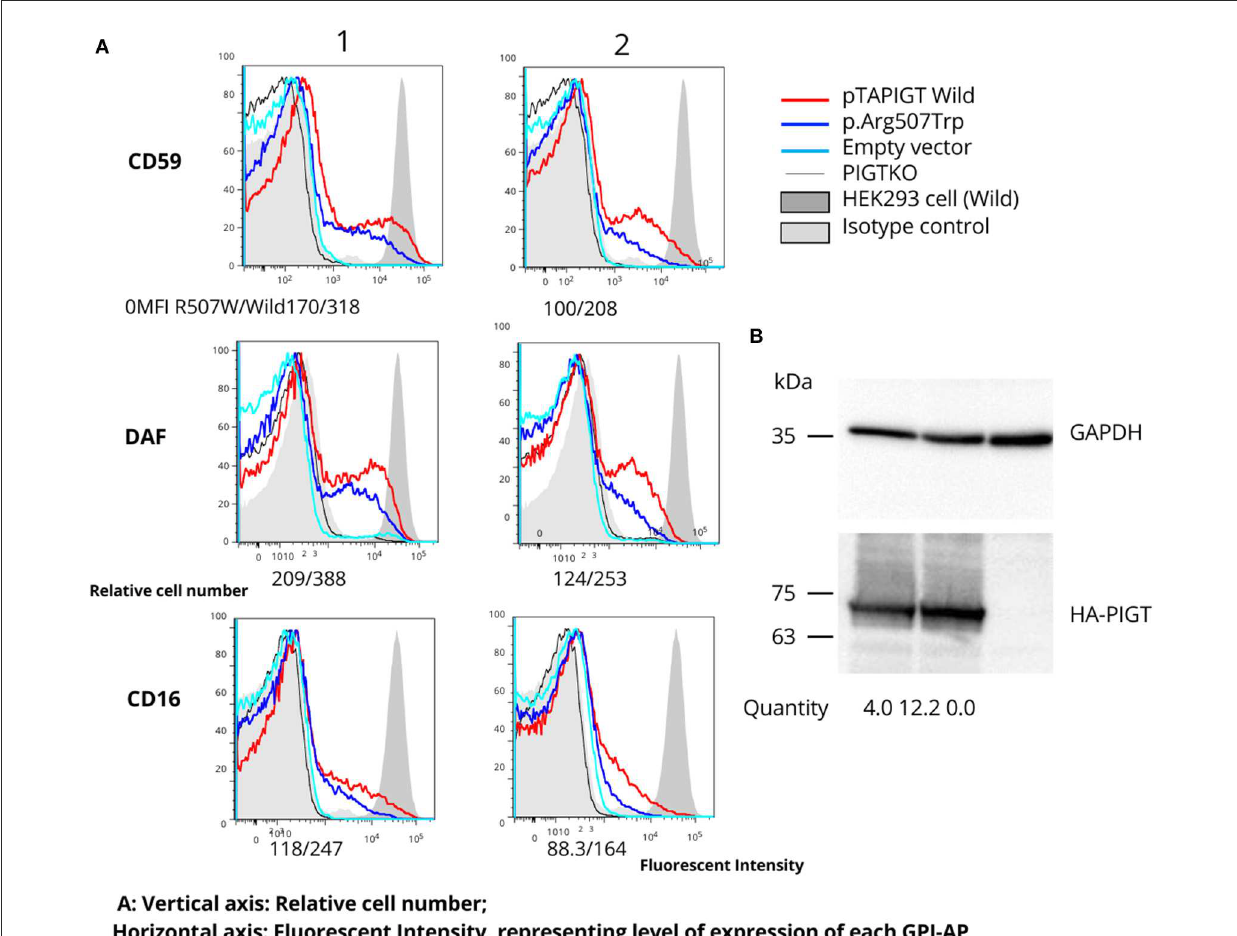
FIGURE2 Follow-up functional studies on the p.Arg507Trp variant. (A) PIGT knockout HEK293 cells were transfected with variable amounts of p.Arg507Trp-variant PIGT or wild-type PIGT expressing plasmids driven by the weak promoter (pTA; 1: 4 ug; 2: 0.8 ug). Restoration of expression of GPI-APs (CD59, DAF, and CD16) was measured using flow cytometry. The p.Arg507Trp variant could not restore GPI-APs at a similar level to wild-type PIGT . The vertical axis represents the relative cell number; the horizontal axis represents fluorescent intensity, reflecting the level of expression of each GPI-AP. (B) Levels of expressed wild-type and p.Arg507Trp mutant HA-tagged PIGT in pME vector-transfected cells were analyzed by western blotting using an anti-HA antibody. After normalization to luciferase activity and GAPDH, expression of the mutant protein appeared to be similar to that of the wild-type